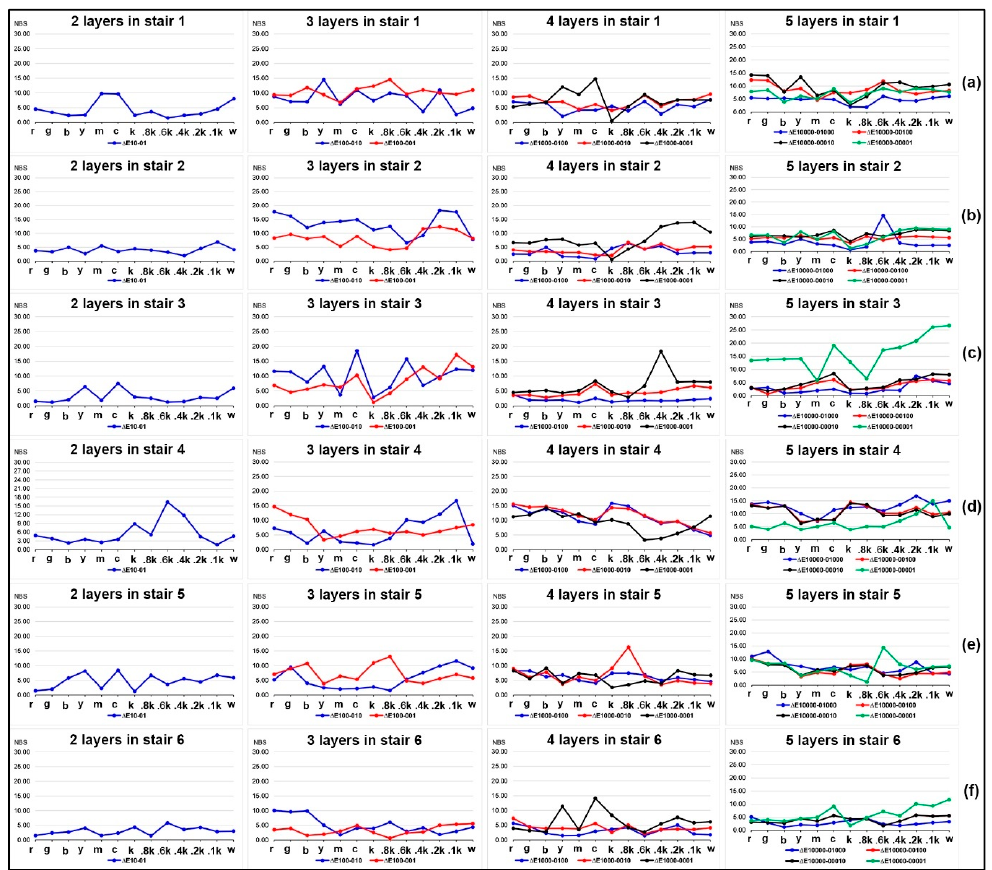
Figure 4. Chromatic aberration of samples for each other comparison: ( a ) stair 1; ( b ) stair 2; ( c ) stair 3; ( d ) stair 4; ( e ) stair 5; ( f ) stair 6.